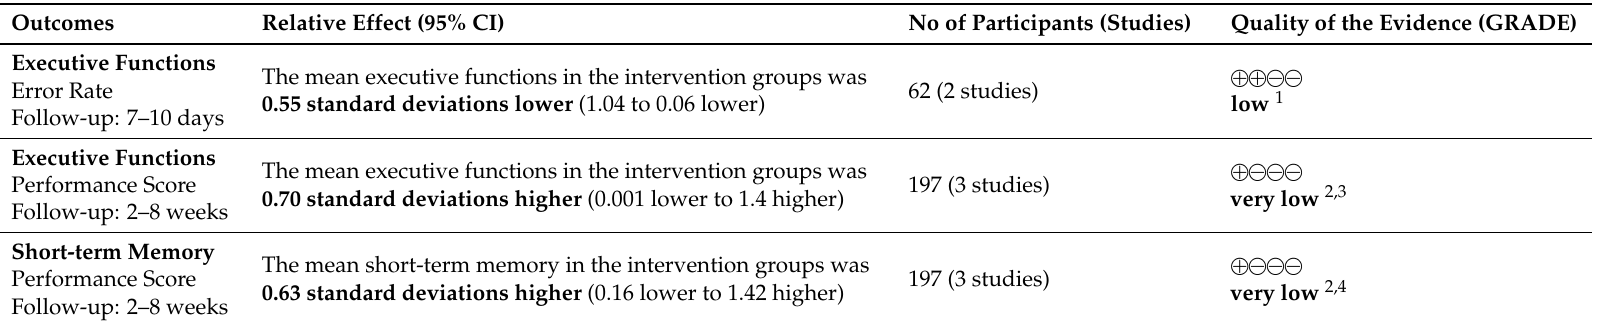
Table 6. Summary of findings (SoF) table for cognitive function outcomes of meta-analysis measured in clinical trials of chicken essence.